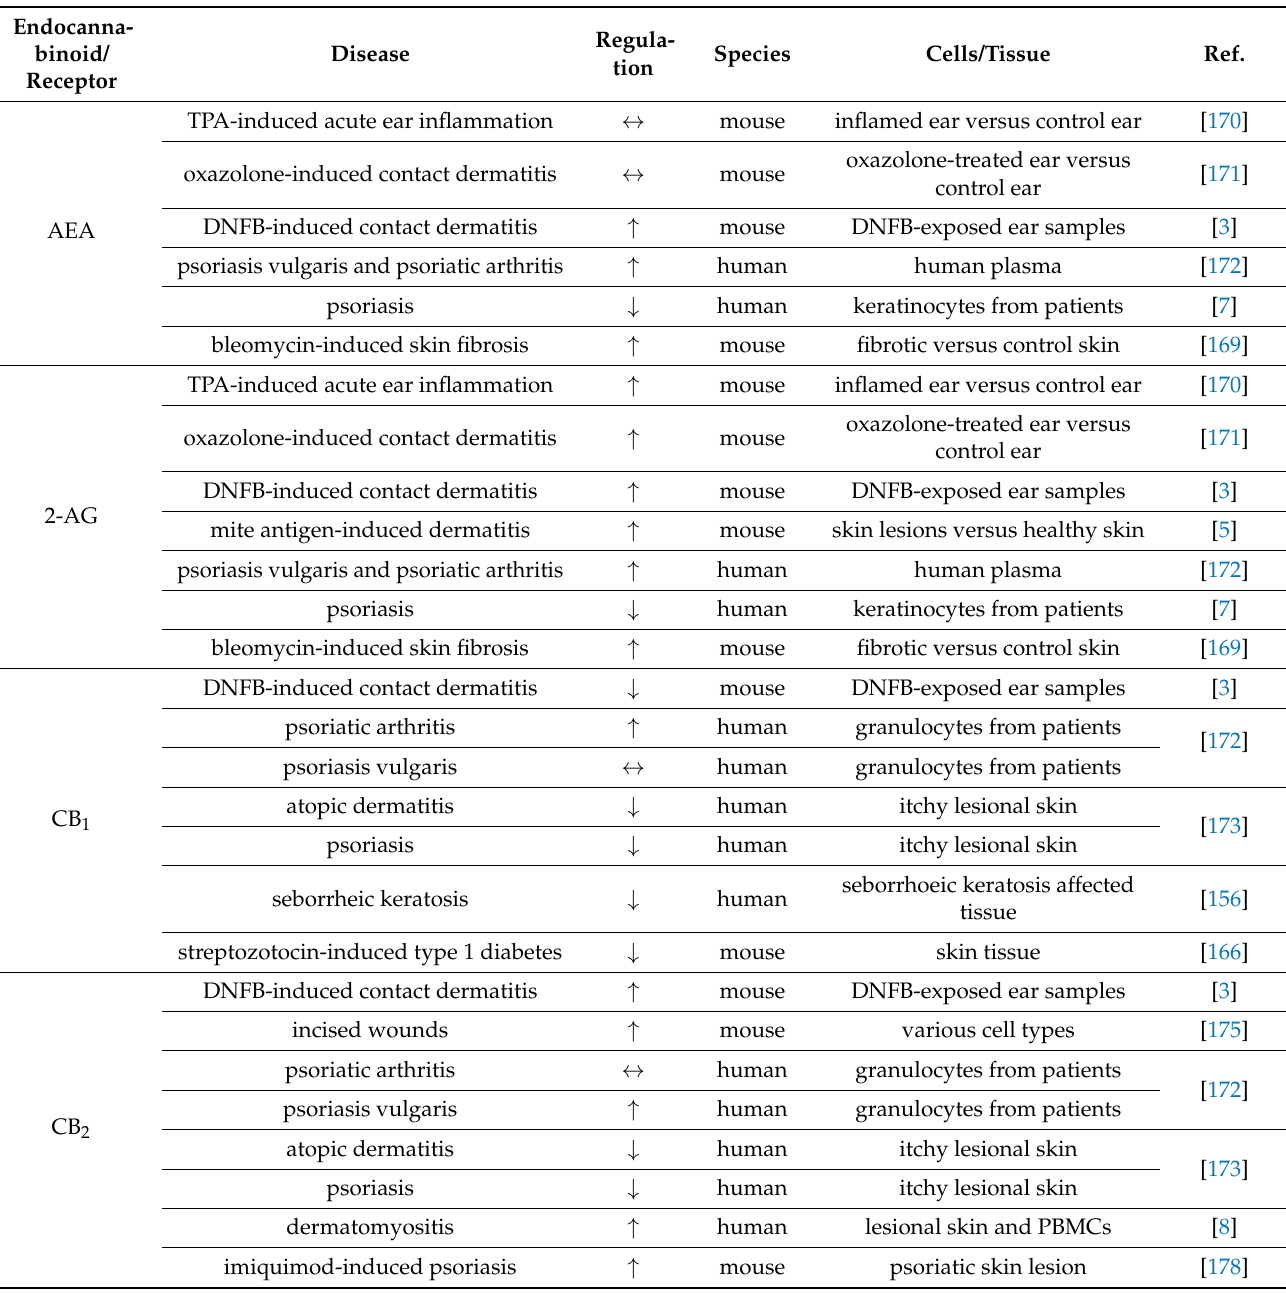
Table 1. Regulation of endocannabinoids and cannabinoid receptors in tissue, plasma or cells from biopsies of skin